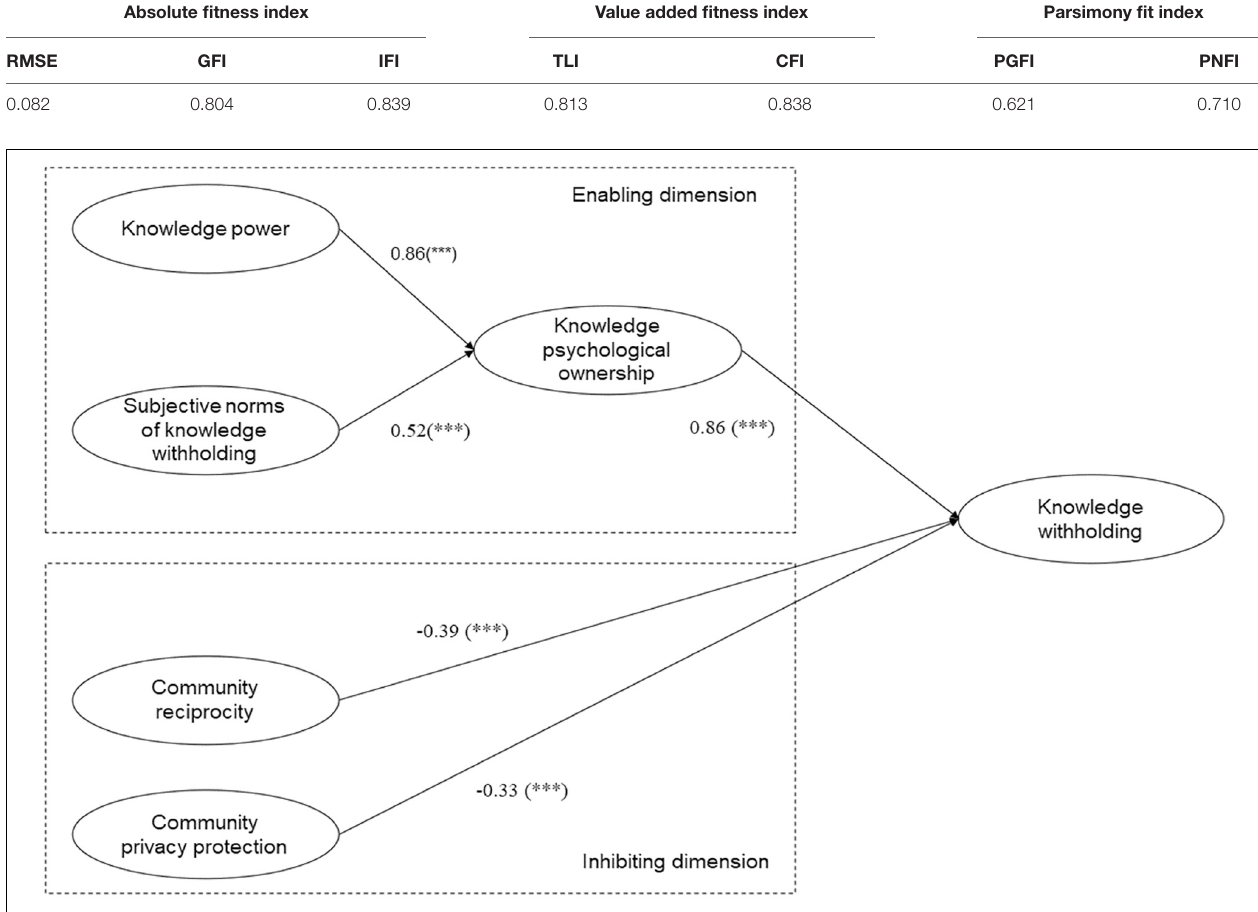
FIGURE 3 | Structural equation method (SEM) path map of knowledge withholding in virtual academic community. *** P < 0.001.